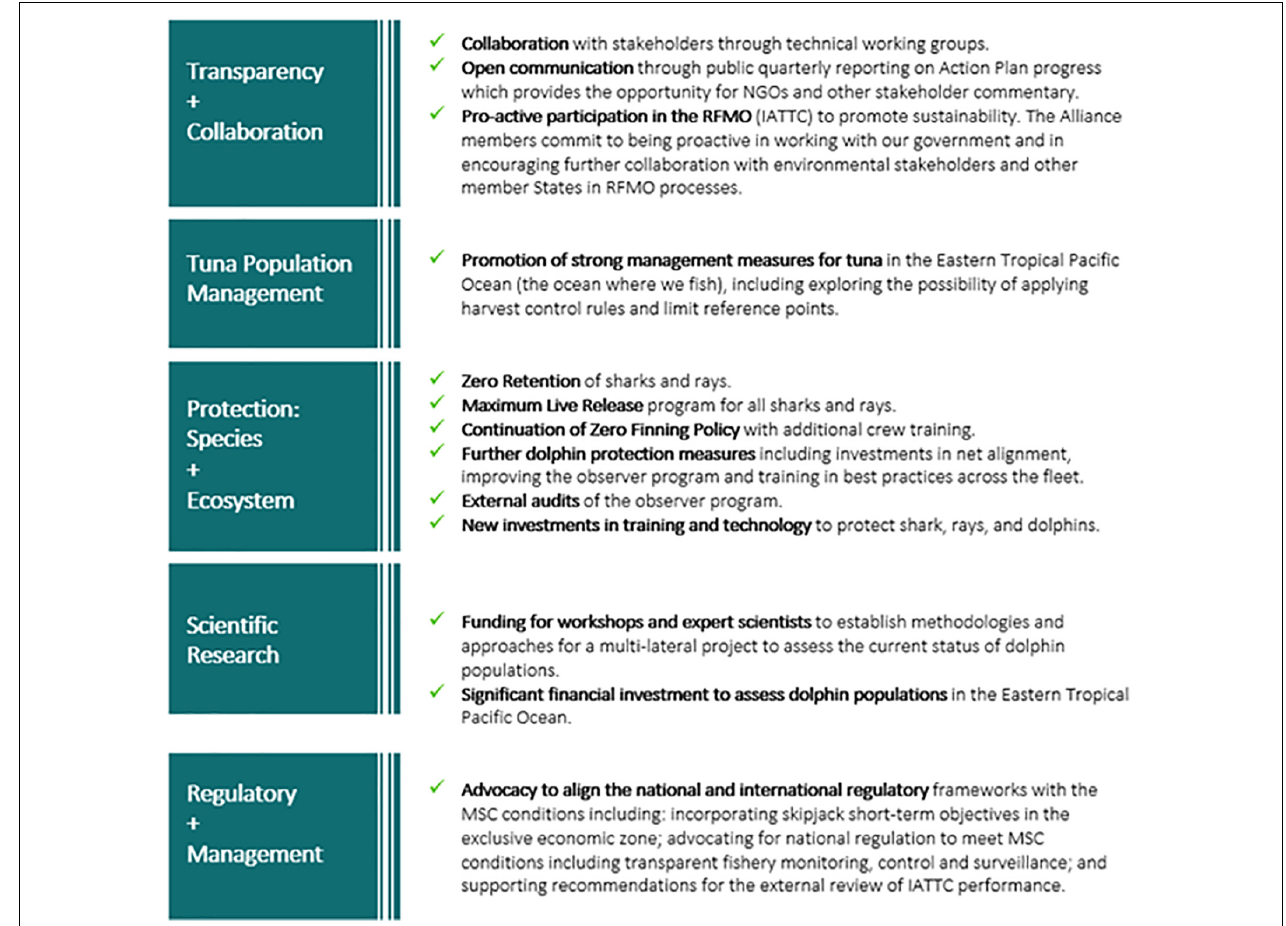
FIGURE 5 | Components of the sustainability action plan of the Pacific Alliance for Sustainability of Tuna. This plan was a condition of the Marine Stewardship Council’s certification of tuna caught by setting on dolphins (downloaded from https://www.pacifictunaalliance.org/sustainability/msc-action-plan.html on 15 May